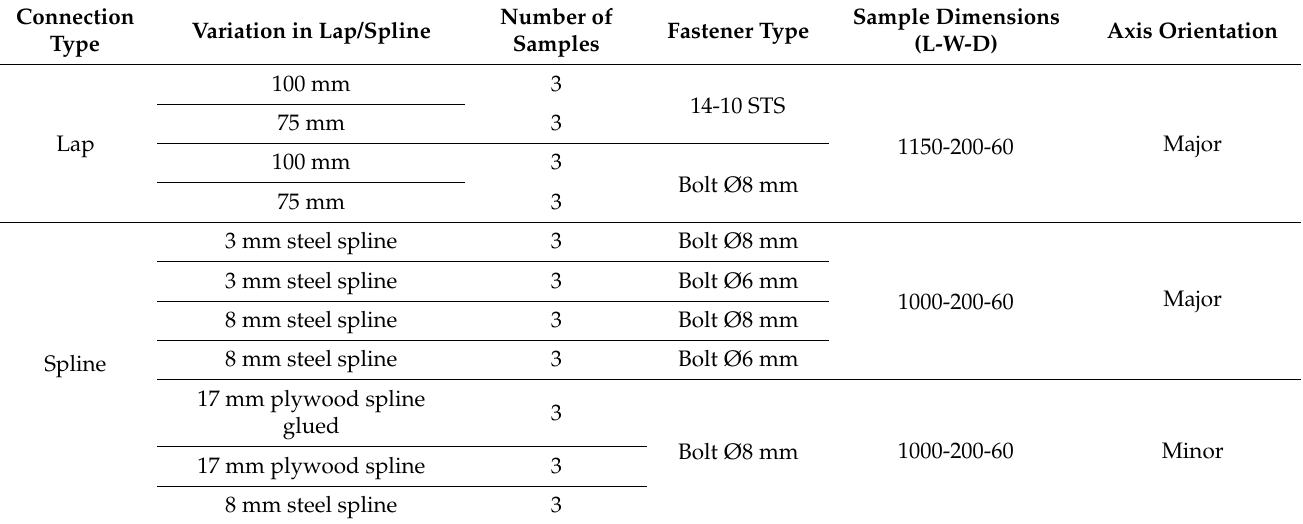
Table 1. Detail of the test matrix used in this study.